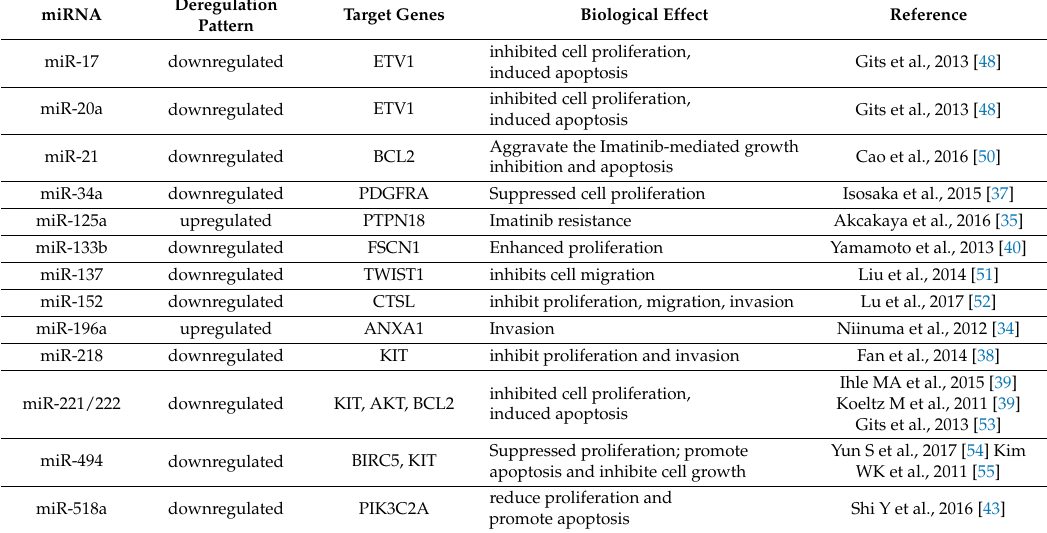
Table 2. Deregulated miRNAs and their target genes in